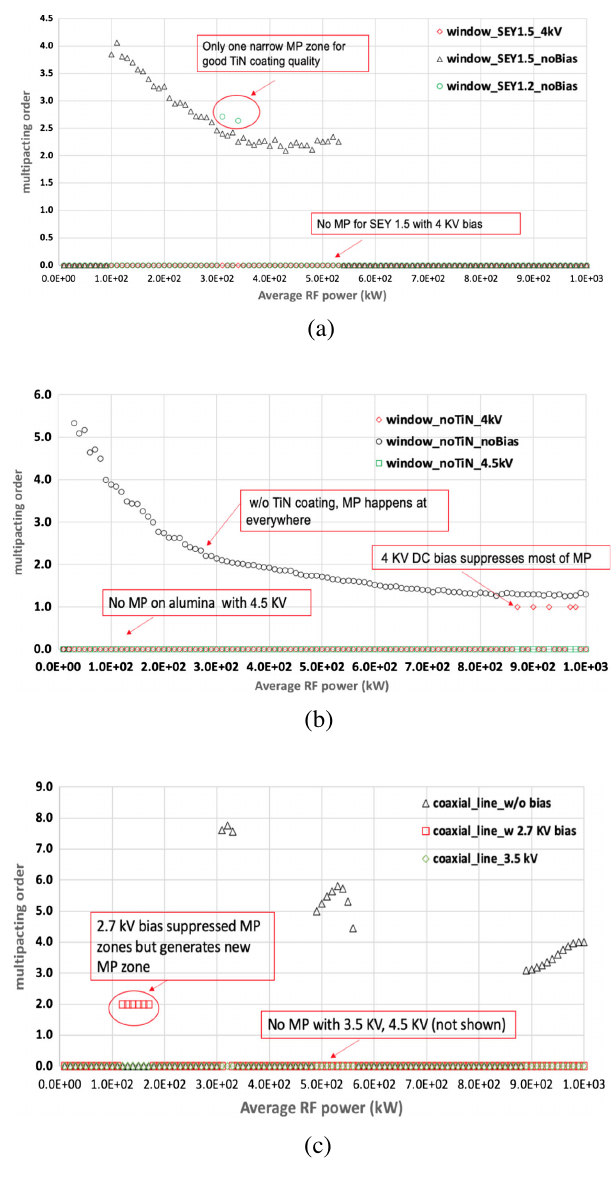
FIG. 9. Multipacting simulation results. (a) Multipacting sim- ulation results in window region with various TiN SEY param- eters. (b) Multipacting simulation results in window region without any TiN coating. (c) Multipacting simulation results in coaxial line